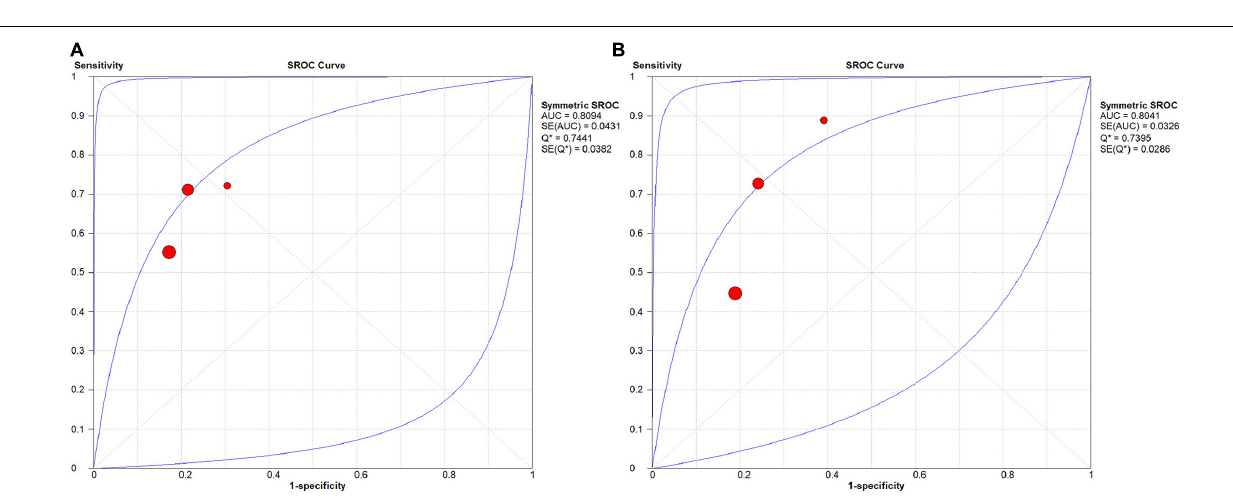
FIGURE 9 | SROC curves for the task of pMCI vs. sMCI classification: (A) SROC curve for the GAN group and (B) SROC curve for the non-GAN